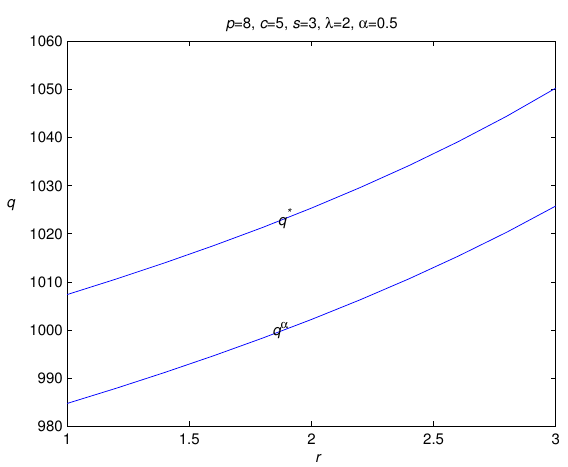
Figure 3. Optimal order quantities q ∗ and q α with different salvage prices r .